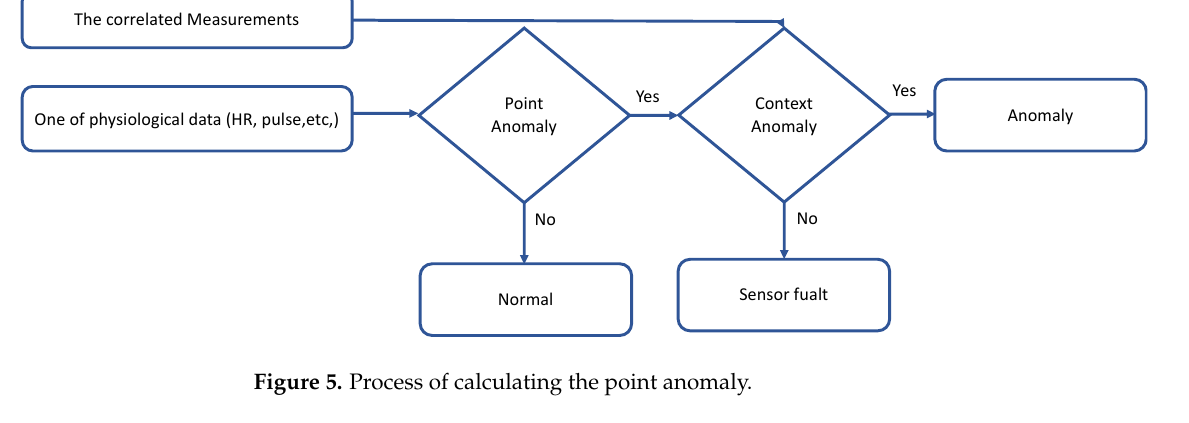
Figure 5. Process of calculating the point anomaly.